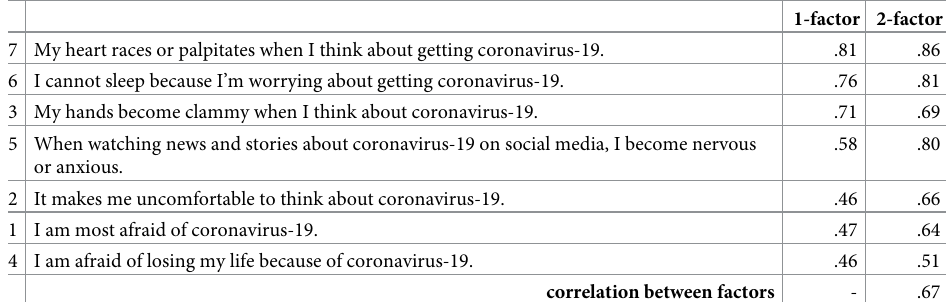
Factor 2 scores were significantly different by gender, age group, occupation, and psychiatric Table 2. Factor loadings of single-factor and two-factor